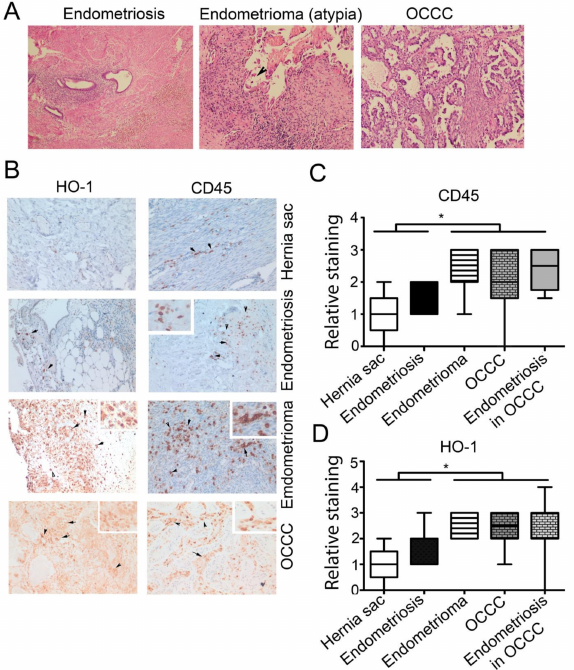
Figure 2. Expression of CD45, HO-1 and Hx in patients with EAOC. ( A ) Representative histology from the following lesions: peritoneal endometriosis, ovarian endometrioma, EAOC clear cell carcinoma. Magnification 200 × . ( B ) Representative lesions and control (hernia sac) immunostained for HO-1 and CD45 highlight stromal macrophages. Magnification 200 × with 400 × inserts. ( C , D ) The graphs showing the relative intensities of stained cells (macrophages), which are higher in cancer tissue and endometriosis lesions in women with cancer, than in endometriosis alone or controls. Mean values +/ − SEM are shown. * p <